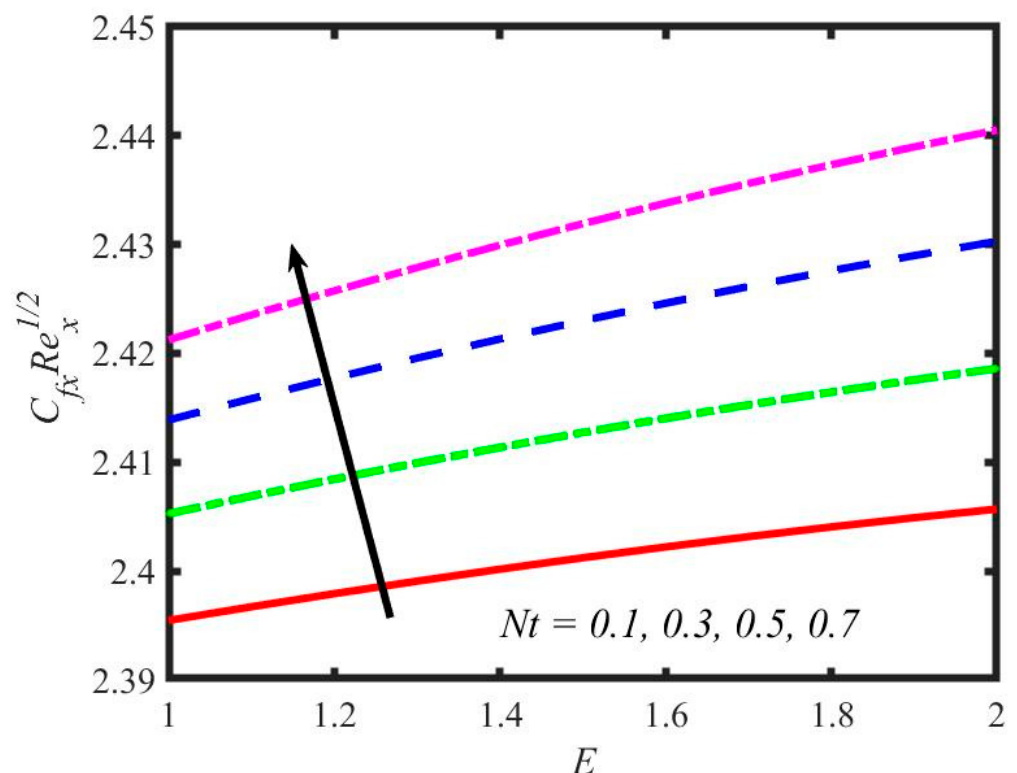
Figure 27. Variations in skin friction coefficient for thermophoresis parameter.